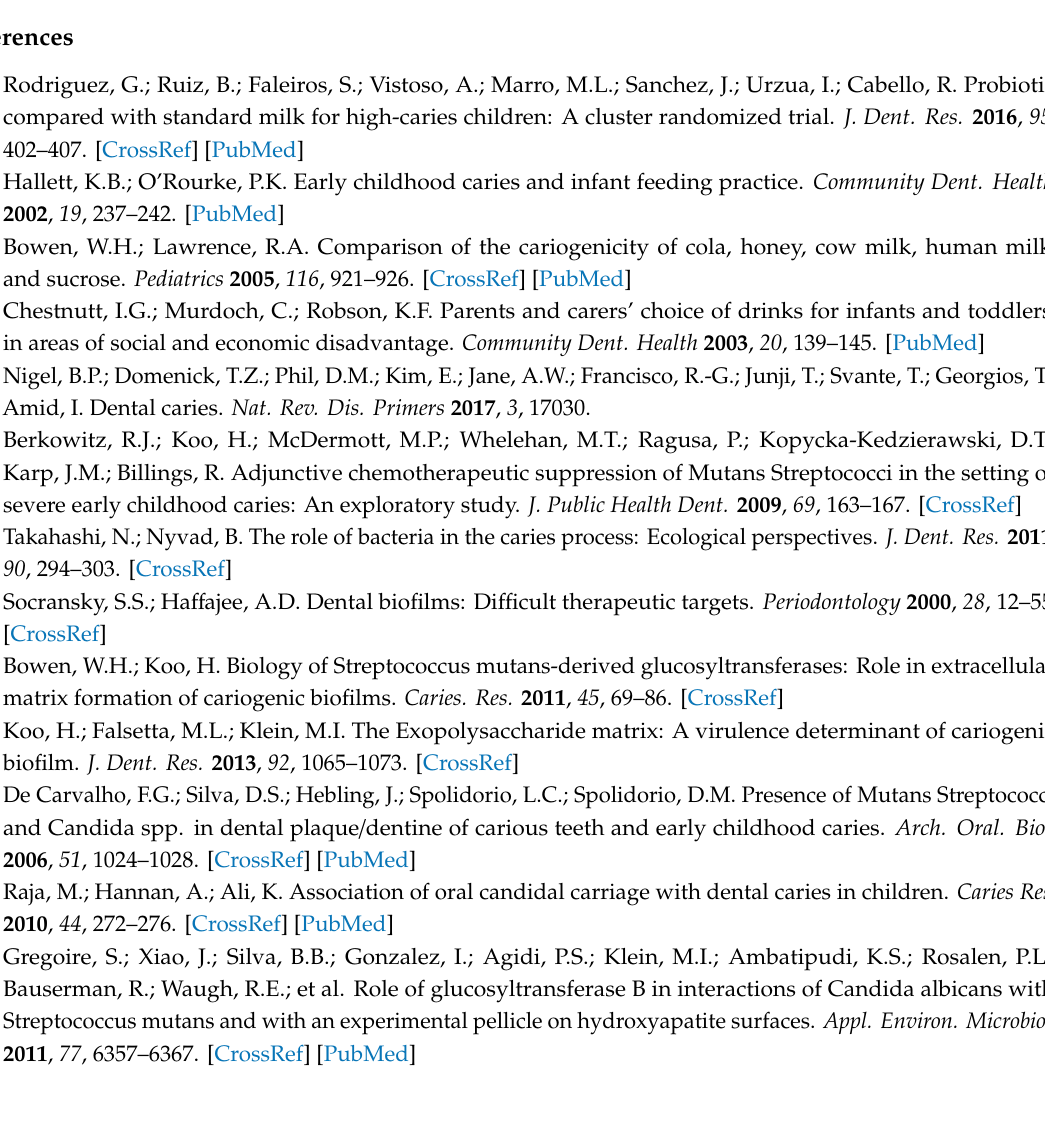
Table S1: Streptococcus mutans gtf gene expression after incubation with Lactobacillus plantarum supernatant; Table S2: Candida albicans hyphal gene expression after incubation with Lactobacillus plantarum